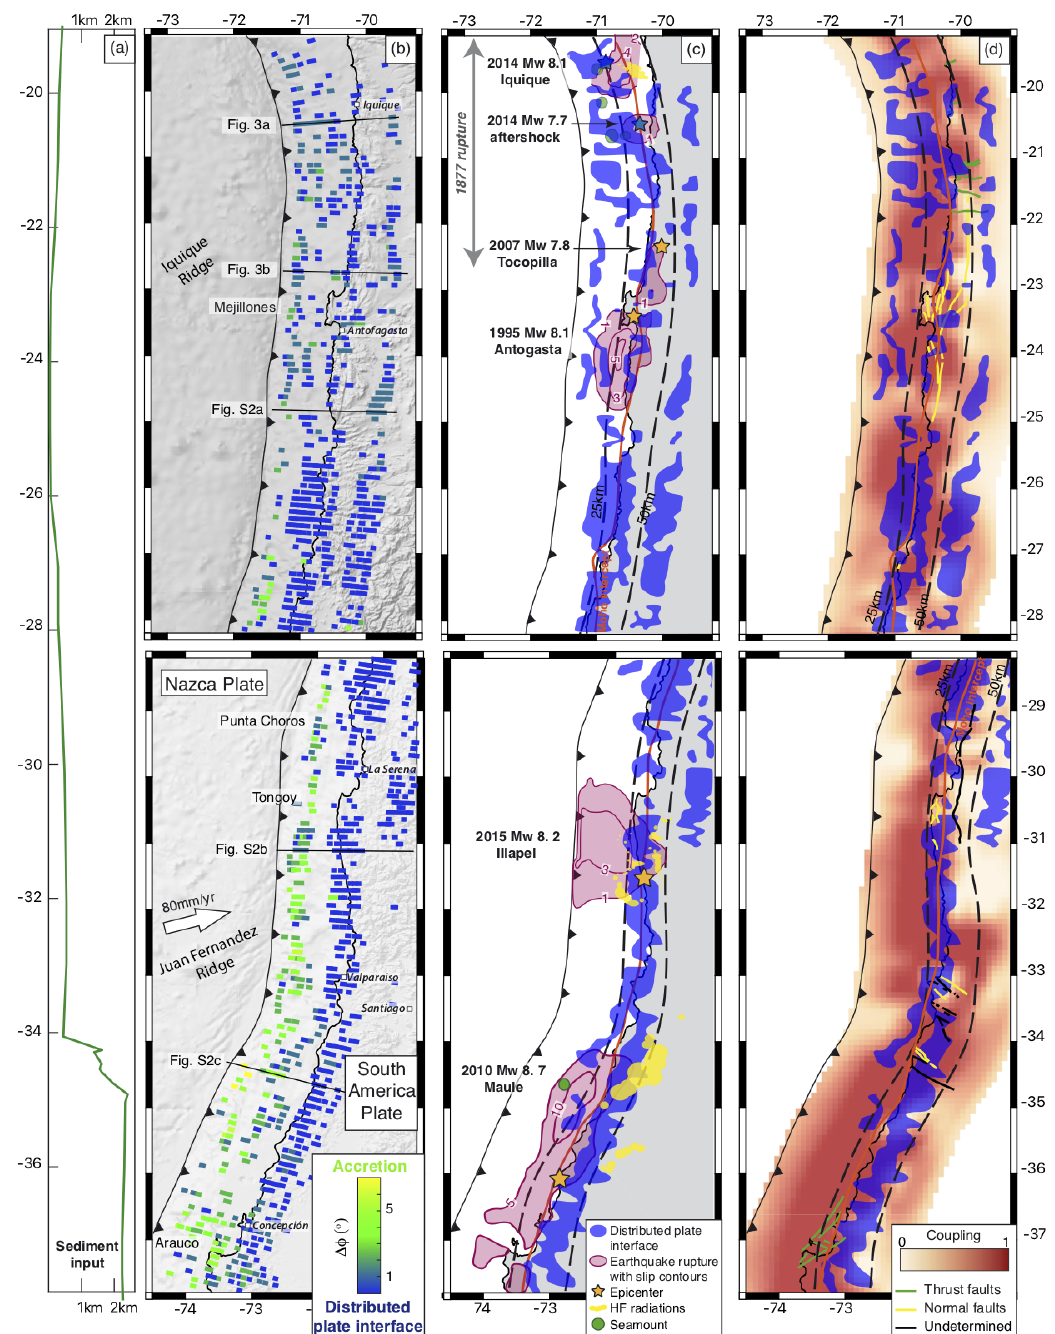
Figure 1. (a) Sediment thickness at the trench (Santibáñez et al., 2018; Tréhu et al., 2019). (b) Difference between internal and basal effective friction of identified critical segments. Large differences lead to standard accretion with thrust faults reaching the surface, while small differences lead to the development of faults parallel to the plate interface, allowing for either basal erosion or underplating. (c) Interpreted patches with distributed deformation along the plate interface related to either basal erosion or underplating compared to last major events: Antofagasta 1995 (Chlieh et al., 2004), Tocopilla 2007 (Béjar-Pizarro et al., 2013), Maule 2010 (Lin et al., 2013), Iquique 2014 and its aftershock (Ruiz et al., 2014b) and Illapel 2015 (Tilmann et al., 2016). Orange stars: Global Centroid Moment Tensor (GCMT) solutions, blue stars: Community Seismic Network (CSN) catalog. High-frequency radiation (yellow; Wang and Mori, 2011; Meng et al., 2015, 2018), identified seamounts (green; Geersen et al., 2015; Maksymowicz et al., 2015), slab depths (dashed black; Hayes et al., 2018) and slab- Moho intercept (orange; Tassara and Echaurren, 2012). (d) Interpreted patches with a distributed plate interface compared to coupling model (Metois et al., 2016) with known active faults (Santibáñez et al., 2018).